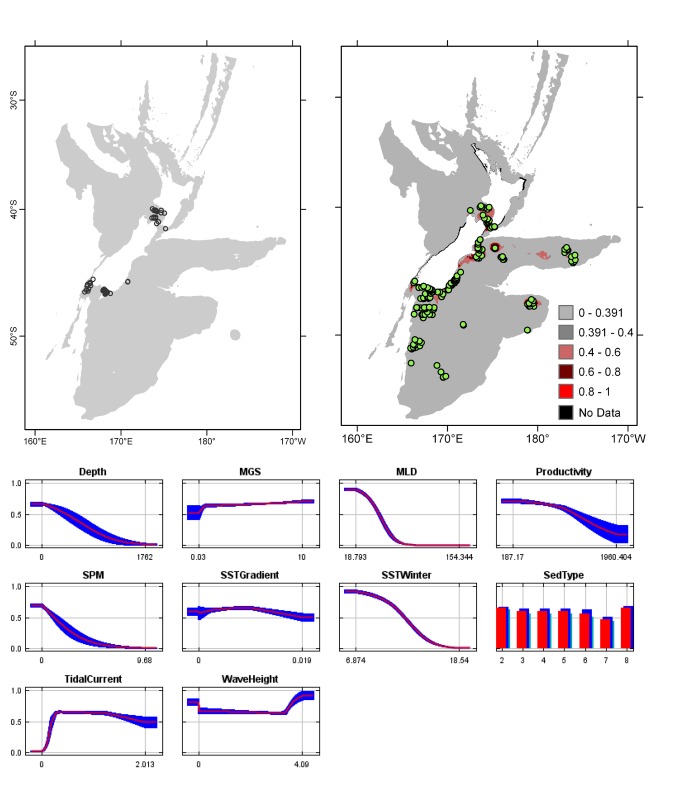

Cinctipora

elegans
 known distribution (left), predicted suitable habitat (right), and fitted responses curves (marginal).For the predicted distribution, logistic probabilities less than the 10th percentile presence value indicated cells were unsuitable habitat. Probabilities of 0.4–0.6 indicated habitat suitability typical of the presence records, values of 0.6–0.8 and 0.8–1 indicated favourable and highly suitable habitat, respectively. Black cells had missing data in one or more environmental layer. Independent records are layed over the predictions. Marginal response curves show how the prediction changes for different values of each variable when all other variables were at their average sample value. Individual response curves are shown in Figure S3. For the categorical variable Sediment type: 1 = deep ocean clays; 2 = calcareous gravel; 3 = volcanic; 4 = calcareous mud; 5 = gravel; 6 = mud; 7 = sand; 8 = calcareous sand.